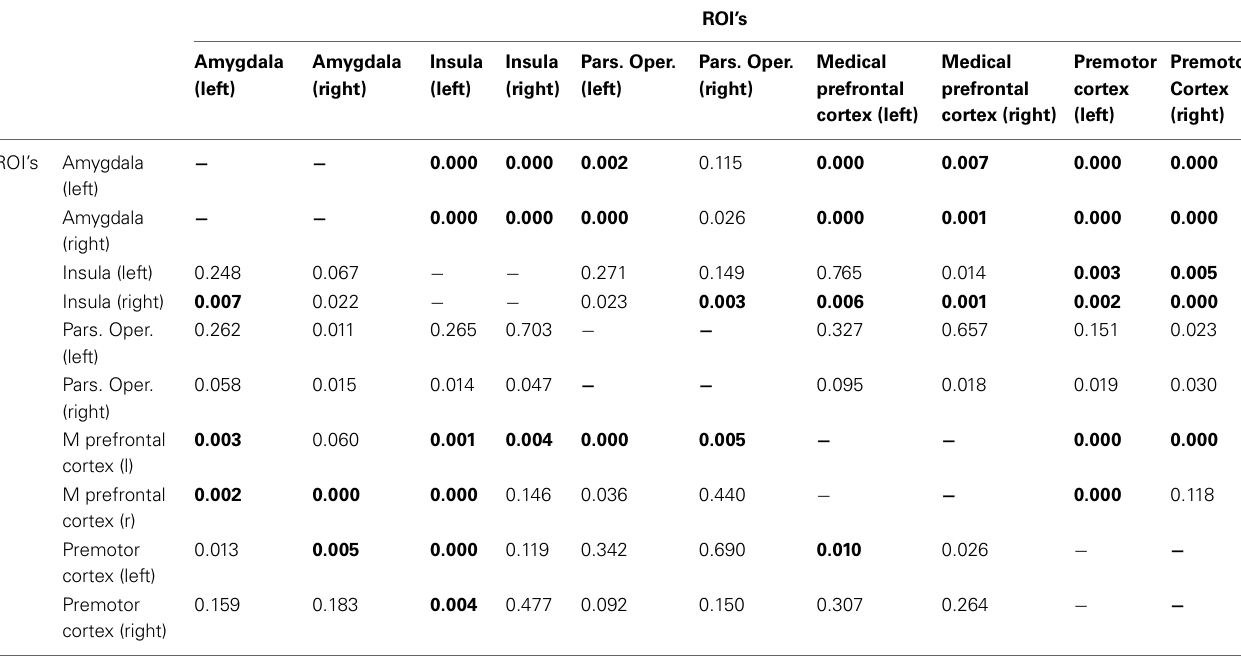
Figures in bold indicate the 1% probability level.